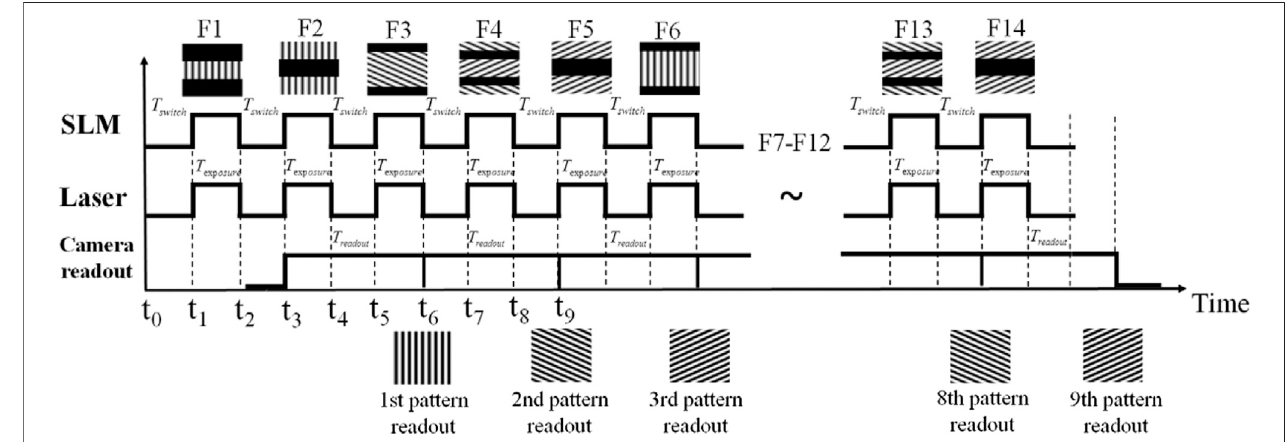
FIGURE5| Themodi fi edsynchronizationcon fi gurationcorrespondingtosegmentedframes[44].Whenthecamerastartstherollingshutterfromthemiddleofthe frame at time t 0 , the fi rst segmented F1 is initially uploaded into the SLM. After the SLM fi nishes uploading F1 at t 1 , the laser begins to illuminate for T exposure and the cameradetectstheemissionfromtheilluminationpatternF1.Att 2 thelaserisofffor T switch andtheSLMstartstouploadthesecondframeF2.Thecamerareadoutstarts at t 3 and the fi rst raw frame receives at t 6 . The fi gure is modi fi ed with permission from Ref. (44). Copyright © 2016 IOP Publishing.